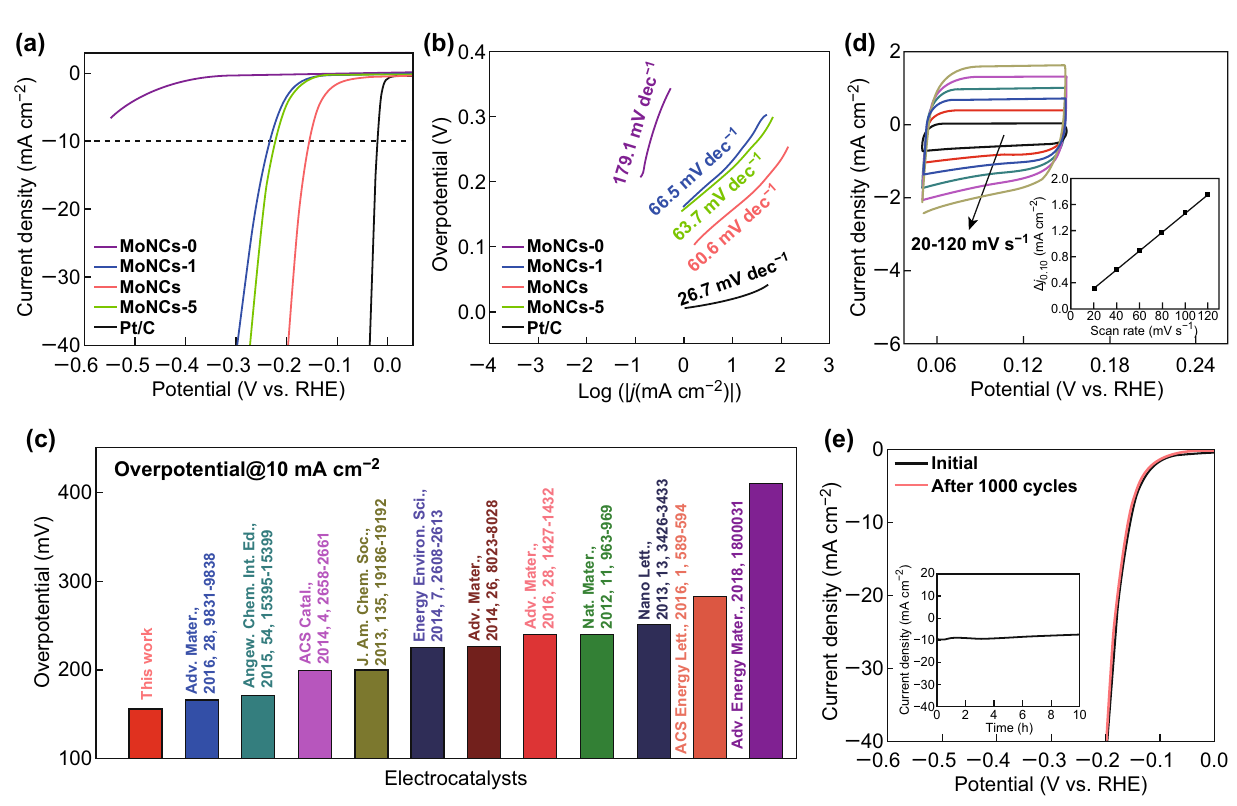
Fig. 4 a LSV curves of a series of samples measured in 0.5 M H 2 SO 4 solution. Scan rate: 2 mV s −1 . b The corresponding Tafel plots. c The overpotentials delivered at 10 mA cm −2 of Mo-based electrocatalysts in recent years. d CV curves of MoNCs. Inset shows the capacitive current measured at 0.10 V versus RHE. e Stability test for MoNCs by CV scanning; inset shows the time-dependent current density curve at a static overpotential of 157 mV for 10